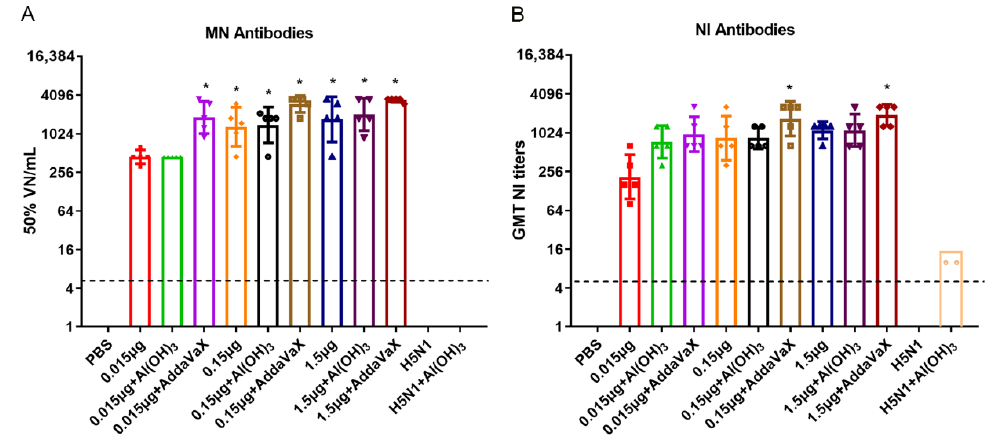
Figure 3. HI titers elicited by H5N8 inactivated vaccine with or without adjuvants. BALB/c mice ( n = 5) were immunized twice with various doses of H5N8 inactivated vaccines with or without adju- vants, or with PBS as a control. ( A ) Serum HI antibodies against H5N8 virus at day 21 post the first immunization were determined by HI assay. ( B ) Serum HI antibodies against H5N8 virus at day 21 post the last immunization were determined by HI assay. Comparing the vaccination effect among various formulations, the asterisk * indicates a significant difference ( p < 0.05) detected by one-way ANOVA.